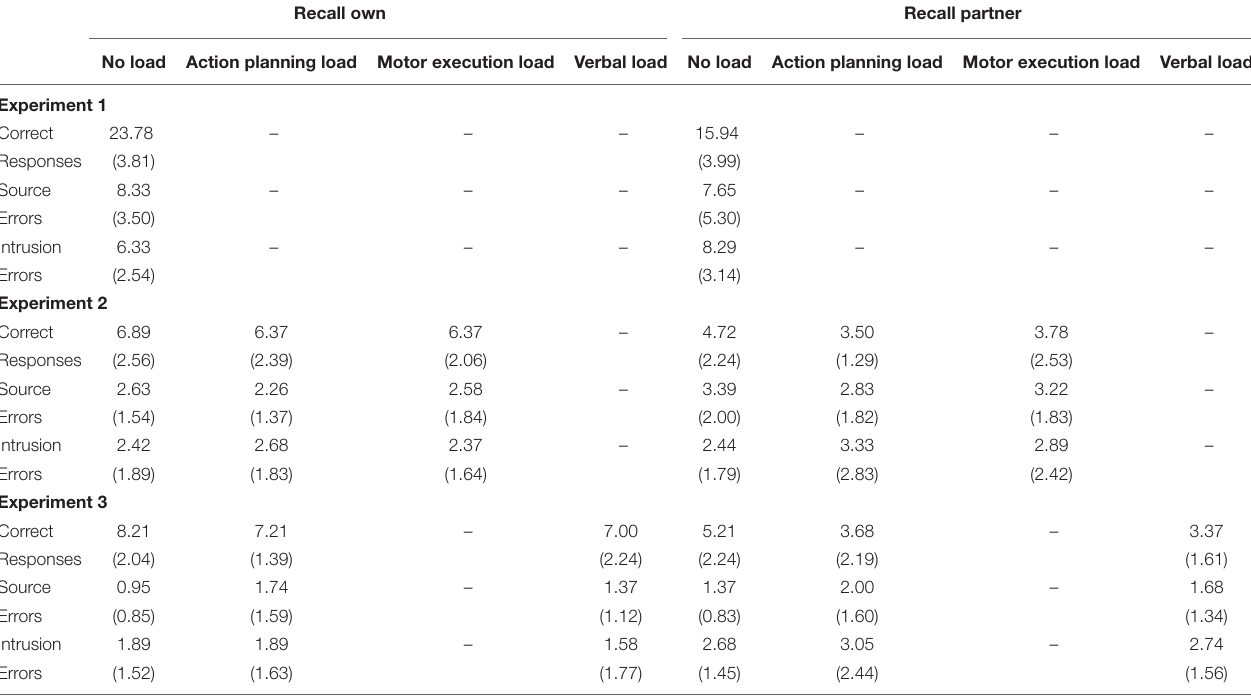
TABLE 1 | Full set of mean frequencies of reported responses (SDs in brackets) in Experiment 1 through 3 for both retrieval tasks and all concurrent load conditions. Recall own Recall